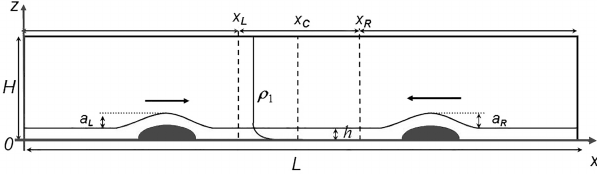
Figure 1. Configuration of the experiment exploring the interaction of ISWs with trapped